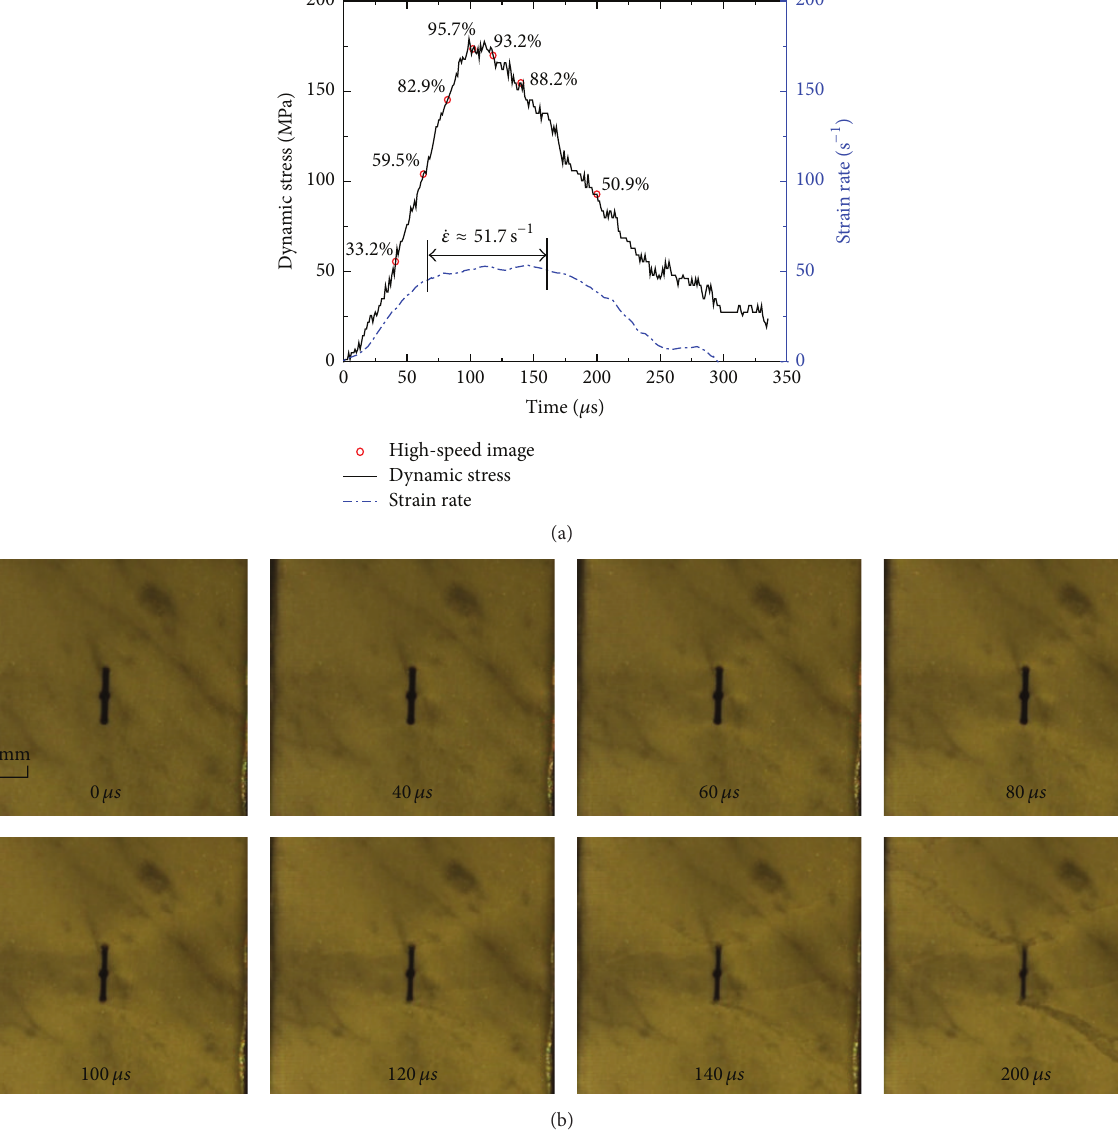
Figure14:Typicalrealtimeofcrackpropagationinprismaticmarblespecimenwithaverticalsinglepreexistingflaw.(a)Completestress-time and strain rate-time curves and (b) high-speed images at different stages (impact loading direction: from right to